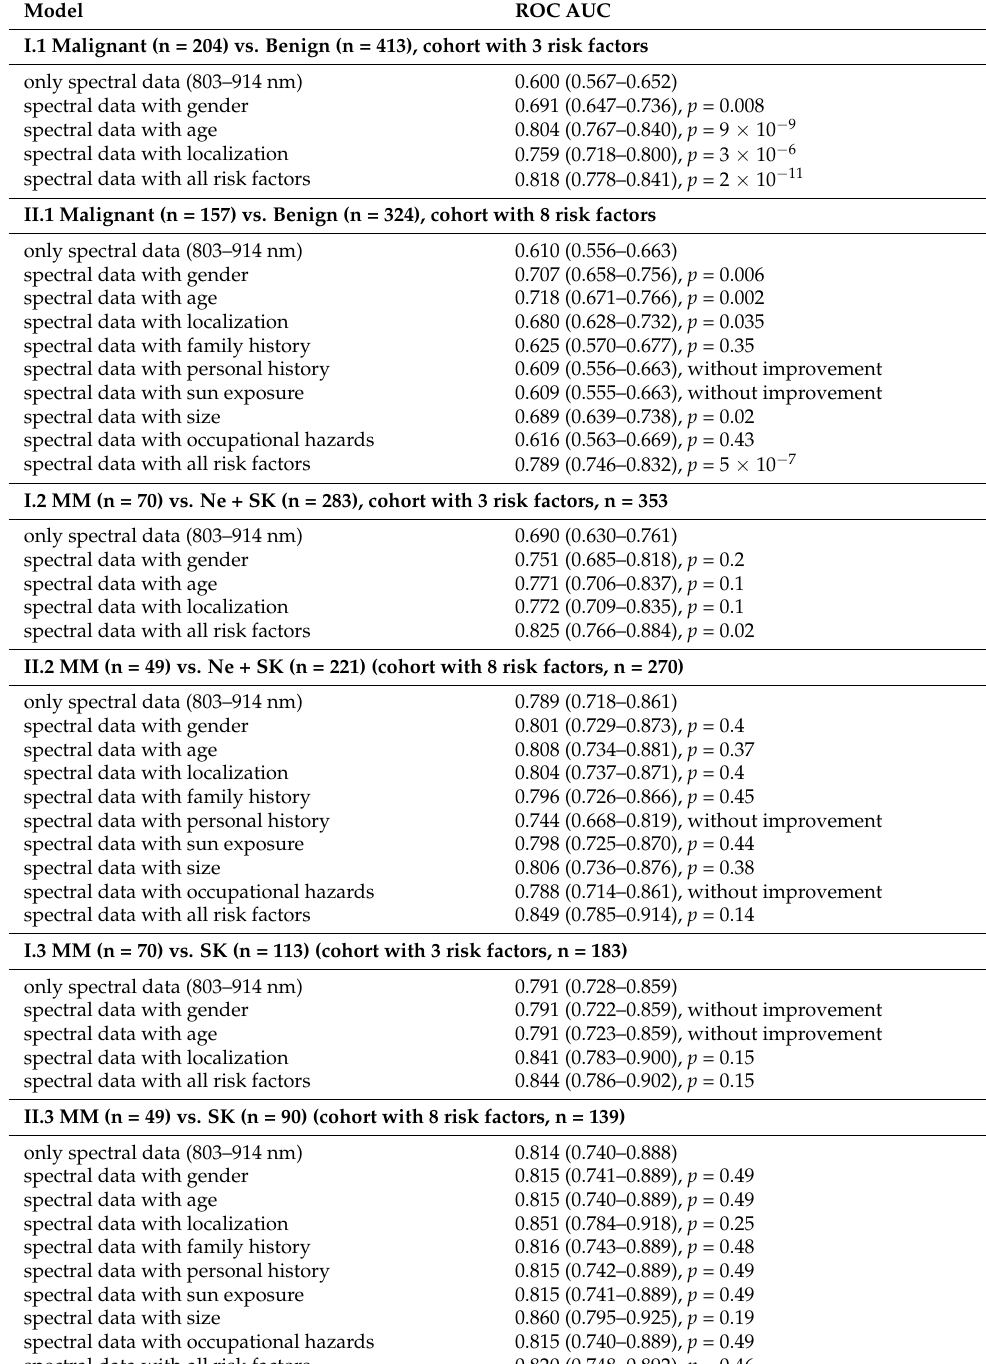
Table 1. Results of regression